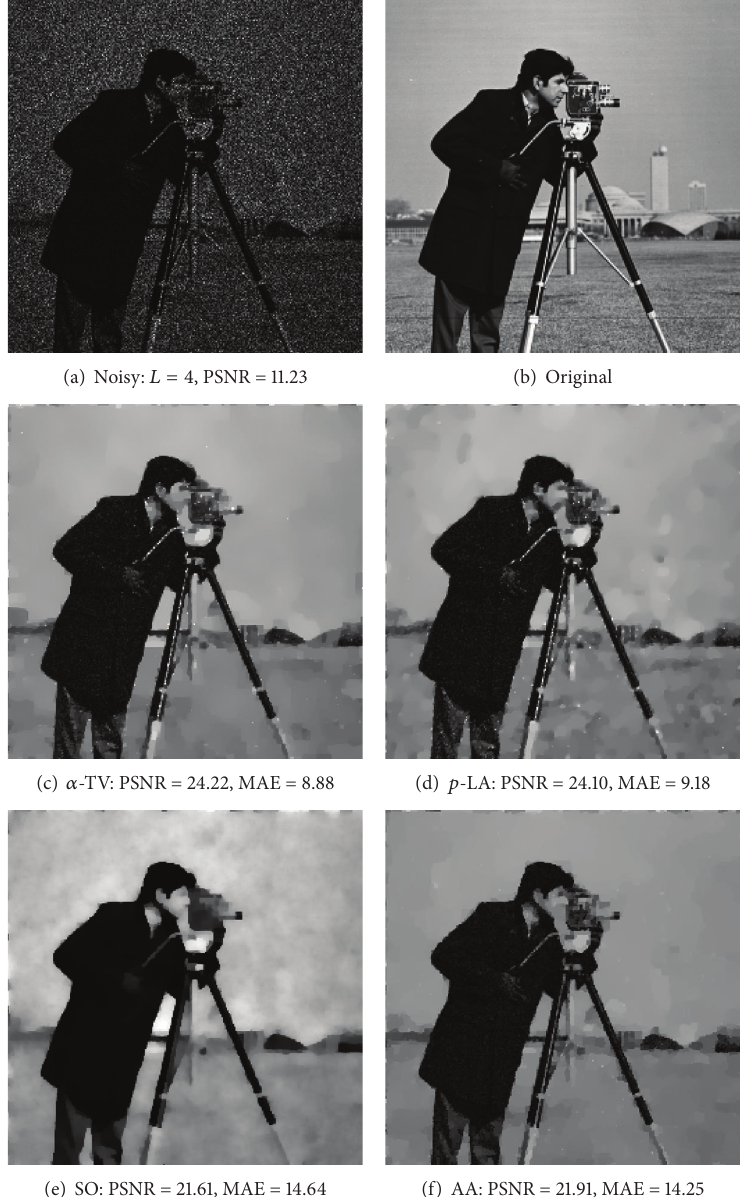
Figure 9: Cameraman image ( 512 × 512 ). (a) Noisy image corrupted by speckle noise for 𝐿 = 4 in (8). (b) Original image. (c) Our algorithm by 𝛼 -TV, 𝜎 = 2 , 𝑘 = 0.005 , and 𝜏 = 0.05 . (d) Our algorithm by 𝑝 -LA, 𝑝 𝑈 = 1.2 . (e) SO algorithm, 𝜆 = 0.2 , 𝛼 = 0.25 . (f) AA algorithm, 𝜆 = 240 .